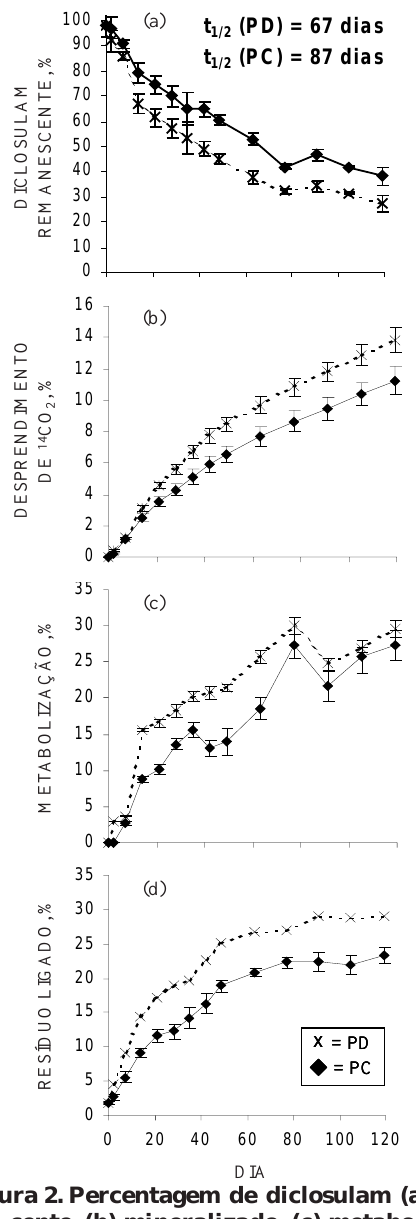
Figura 2. Percentagem de diclosulam (a) remanes- cente, (b) mineralizado, (c) metabolizado e (d) na forma de resíduo ligado e remanescente no Latossolo Vermelho distroférrico cultivado há 10 anos sob plantio direto (PD) ou convencional (PC). As barras verticais correspondem ao desvio-padrão da